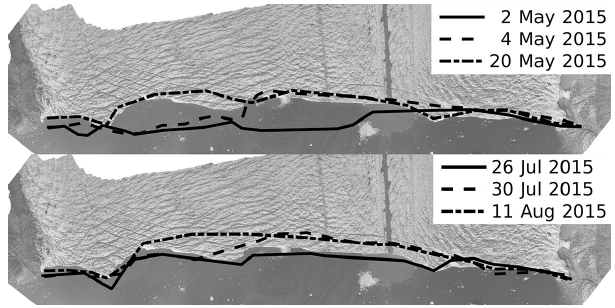
Figure 1. Positions of the calving front of the Bowdoin Glacier in- ferred from satellite images before and after the calving events of 3 May, 19 May, 27 July and 9